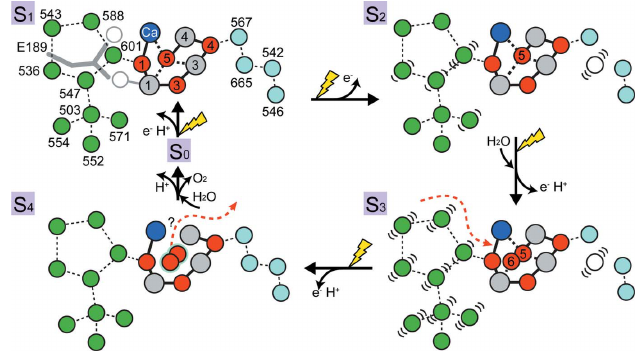
Figure 7 Structural changes in the OEC and water molecules found in the present and previous studies are summarized. Red and gray spheres with numbers in the OEC are oxygen and manganese atoms, respectively, and the Mn2 and O2 atoms have been omitted for